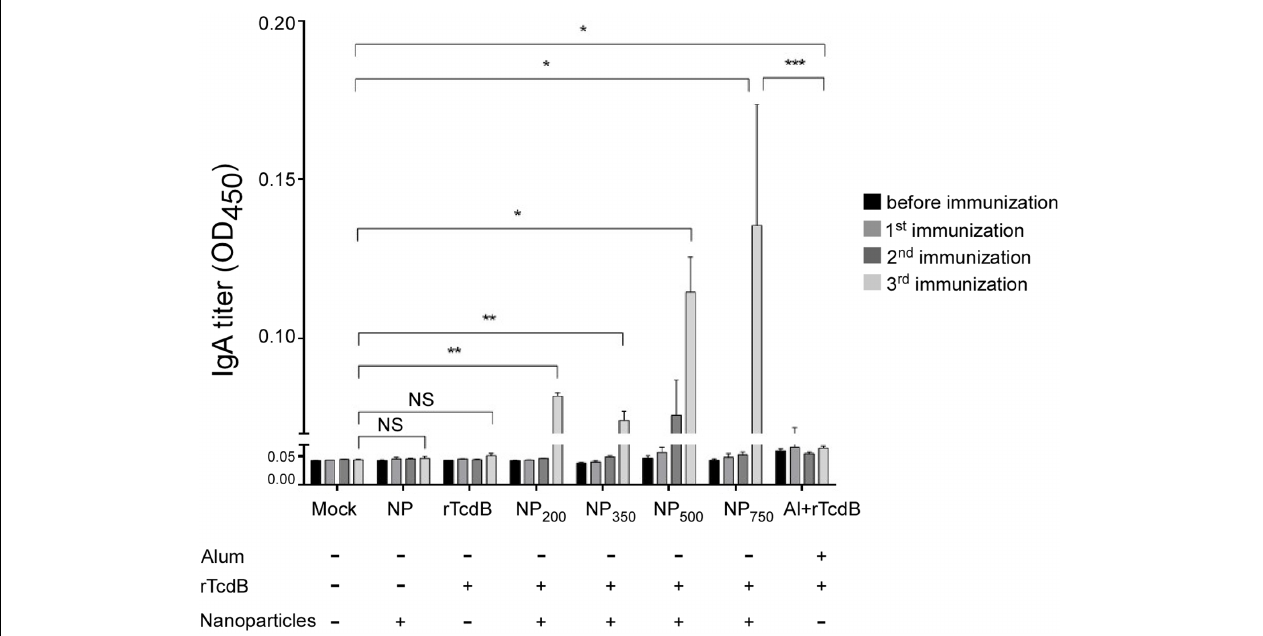
FIGURE 3 | Induction of antigen-specific IgA in nanoparticle vaccinated mice. ELISA was performed in triplicate using coated peptide pool. Serum IgAs (1:1,000 dilution) in differentially immunized mice were compared ( n = 5 per group). Mock: PBS injection only; NP: empty nanoparticle infection; rTcdB: injection with 20 µ g purified rTcdB in PBS. NP 200 , NP 350 , NP 500 , and NP 750 : injection with NP-rTcdBs with the corresponding size in nanometers; Al+rTcdB: injection with 20 µ g purified rTcdB mixed with Alum. All data are presented as mean ± standard deviations and statistical comparisons among groups were analyzed by Student’s t -test